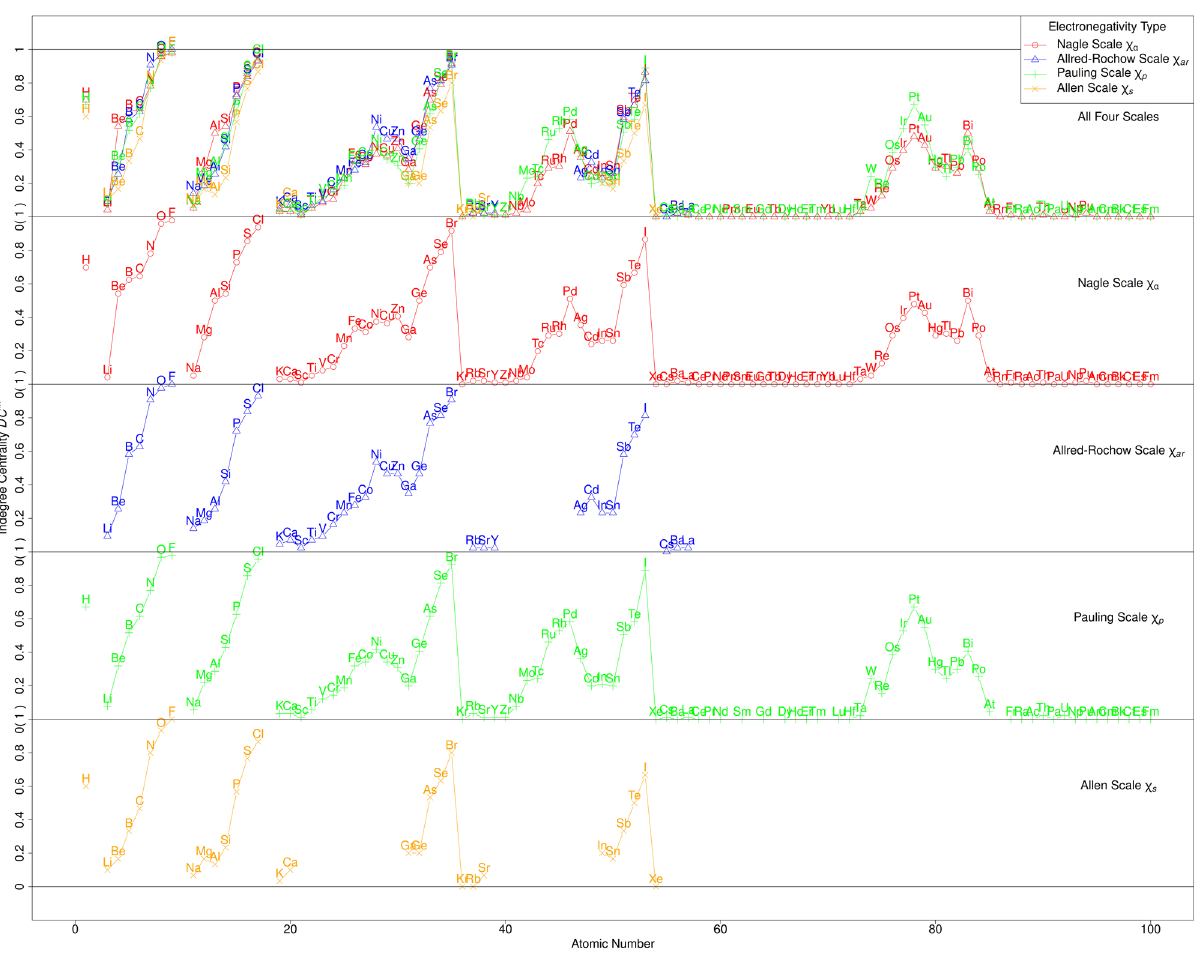
Figure 6: DC in changing trends in the four